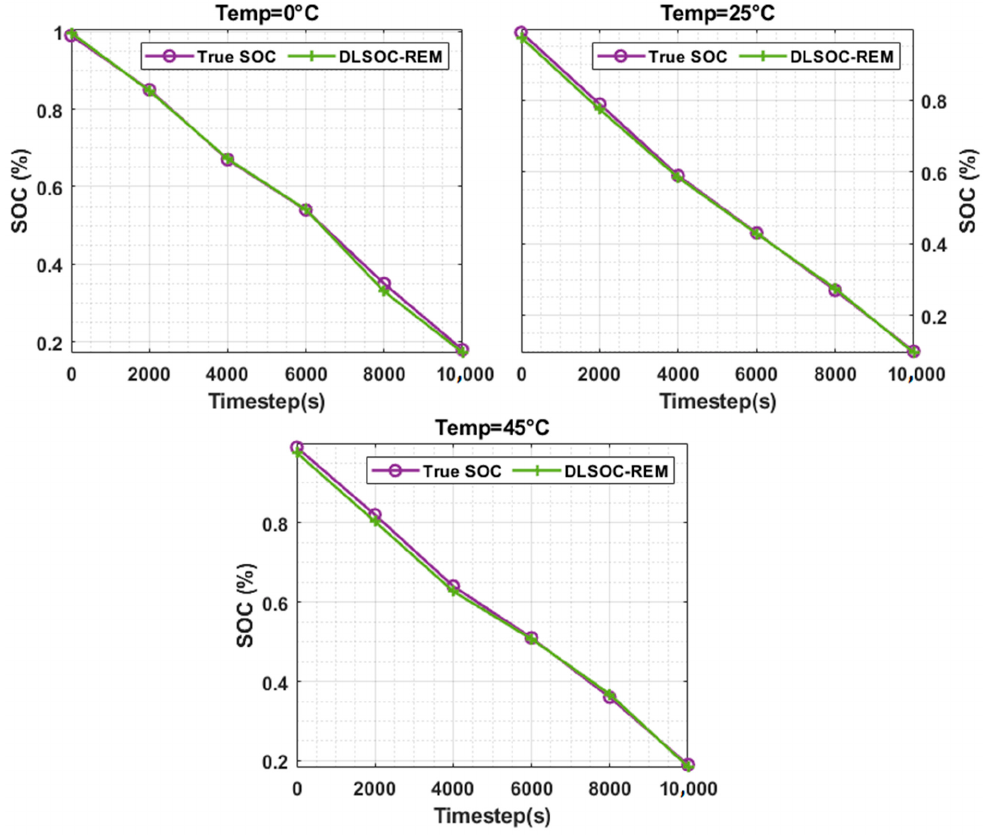
Figure 7. SOC analysis of DLSOC-REM technique on BJDST drive cycle.